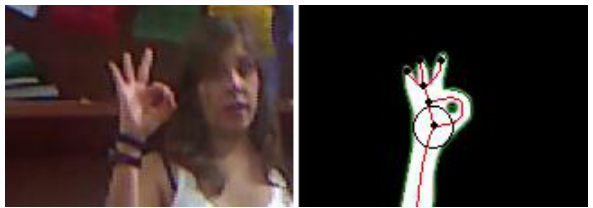
Figure 1. Original image (left), image with keypoints